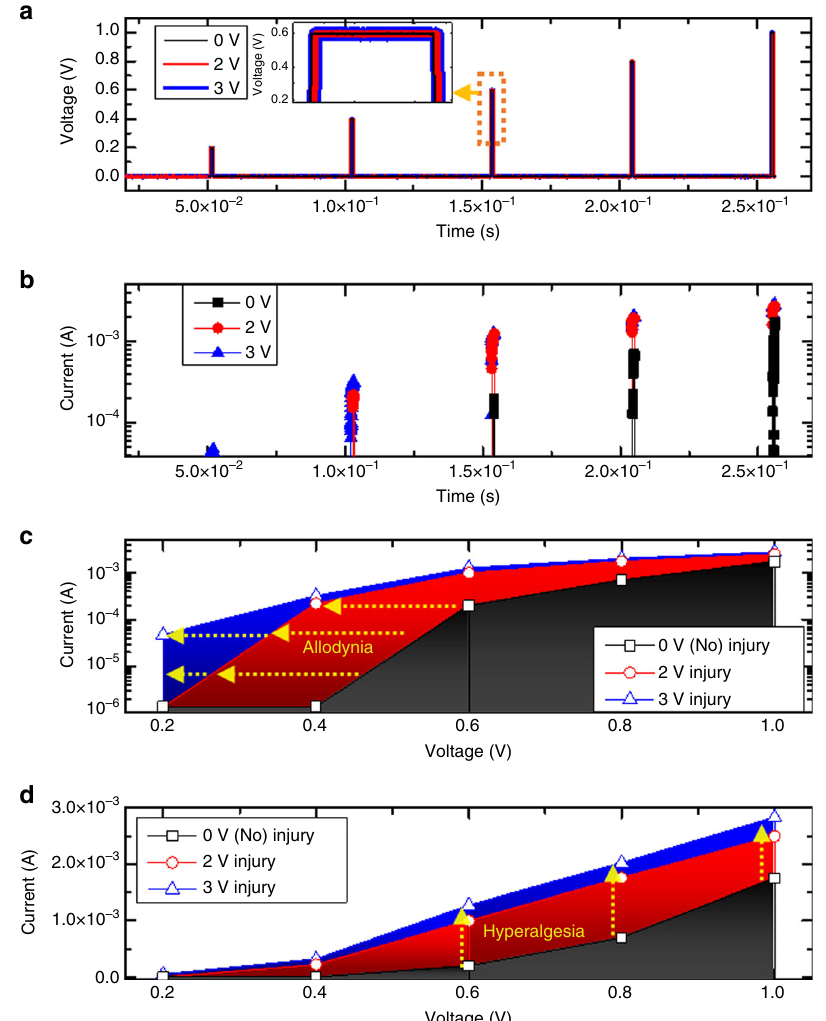
Fig. 4 Allodynia and hyperalgesia demonstration of a memristive nociceptor. a A train of input voltage pulses composed of a variable range of pulse amplitudes from 0.2 V to 1.0 V, with a 1 ms pulse width applied on a nociceptor subjected to different set pulses (0 V as reference and 2, 3 V with a 1 ms width as injury cases) fi rst and ( b ) the corresponding output currents, respectively. The maximum output currents at a different input voltage amplitudes ( c ) in log scale and ( d ) in linear scale, demonstrating the shift of the ON-switching voltage towards a lower threshold (Allodynia) and the ON current towards higher currents